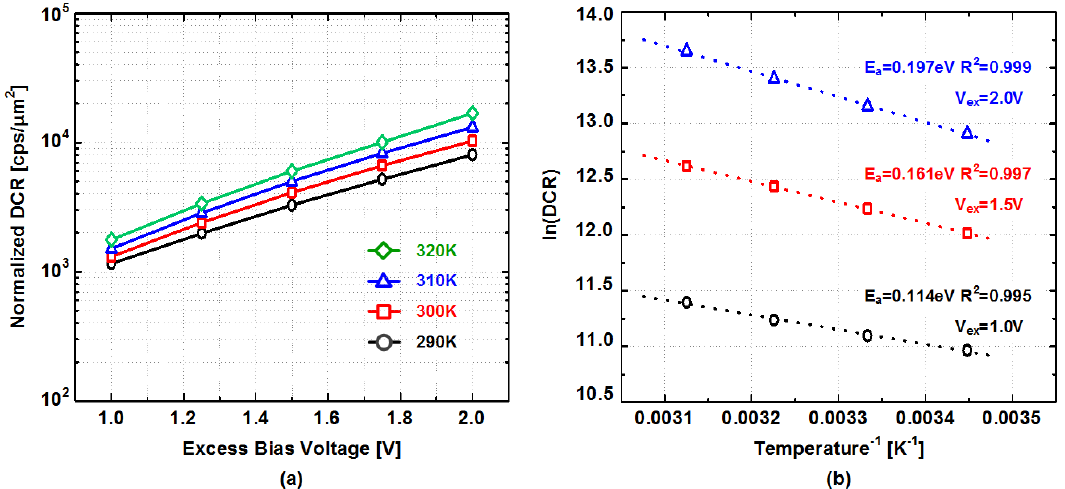
Figure 4. ( a ) Normalized dark-count rate (DCR) as a function of V ex at different temperatures; ( b ) Arrhenius plot with extracted activation energy and determination coefficient for the curve fit (dotted line).